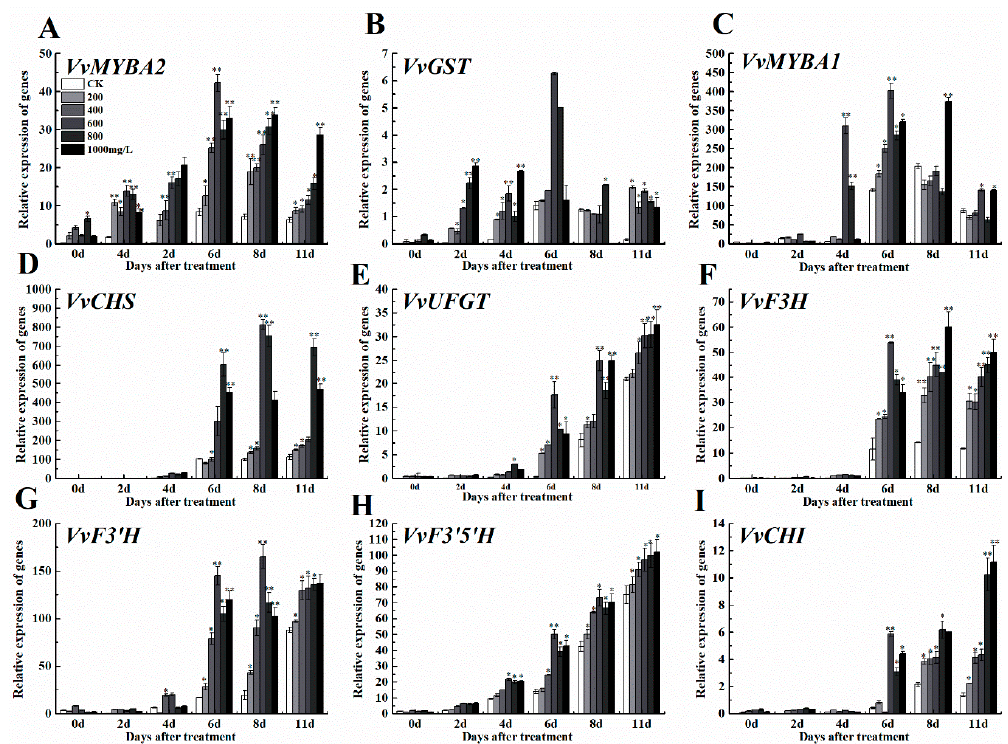
Figure 4. Effect of ethephon on anthocyanin-related genes expression in grape. ( A ) VvMYBA2 , ( B ) VvGST , ( C ) VvMYBA1 , ( D ) VvCHS , ( E ) VvUFGT , ( F ) VvF3H , ( G ) VvF3’H , ( H ) VvF3’5’H , ( I ) VvCHI . Ethephon was used in di ff erent concentrations (200, 400, 600, 800, and 1000 mg / L) and in a time course experiments (2, 4, 6, 8, and 11 days). Values are means ± SD of three biological replicates. * Significant di ff erences compared with the control (water-treated fruits) sample at p < 0.05, ** Significant di ff